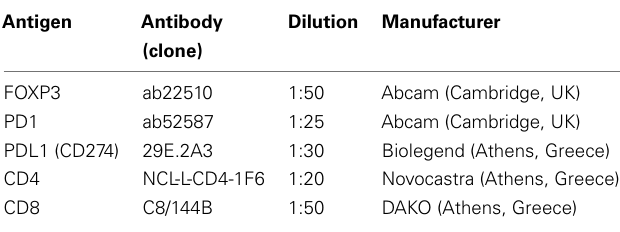
Table 3 |Antibodies and dilutions used in the present immunohistochemical